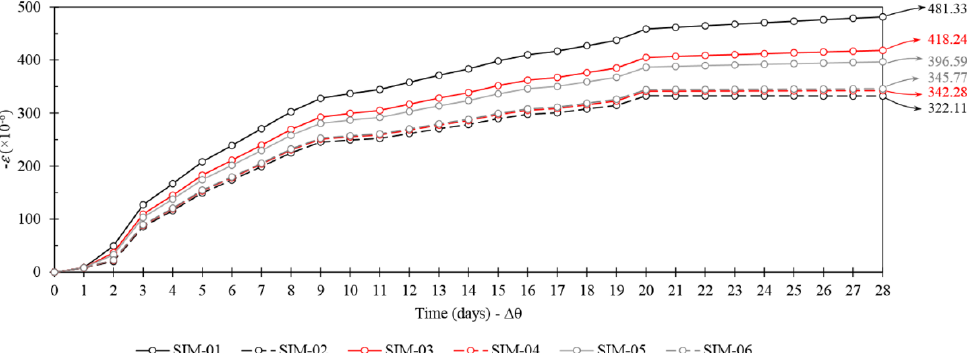
Figure 11. Imposed curing strains in the curing_process